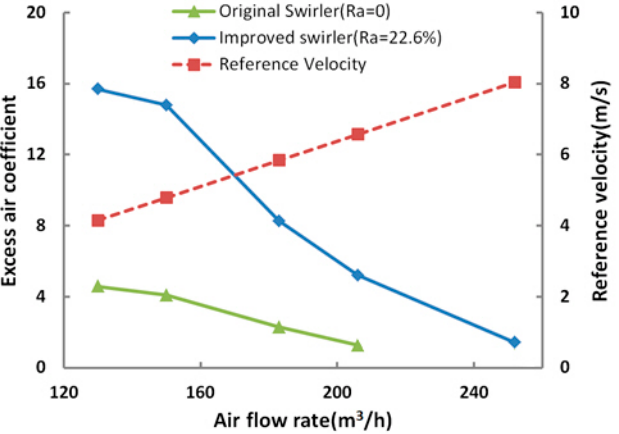
Figure 6. Excess air coefficient of blowout and reference velocity as function of air flow rate.